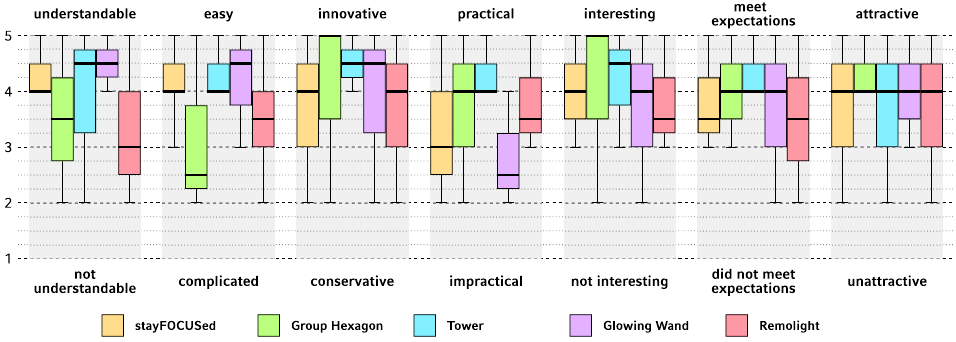
Figure 8. Median and range of developed tangible tools’ usability in our